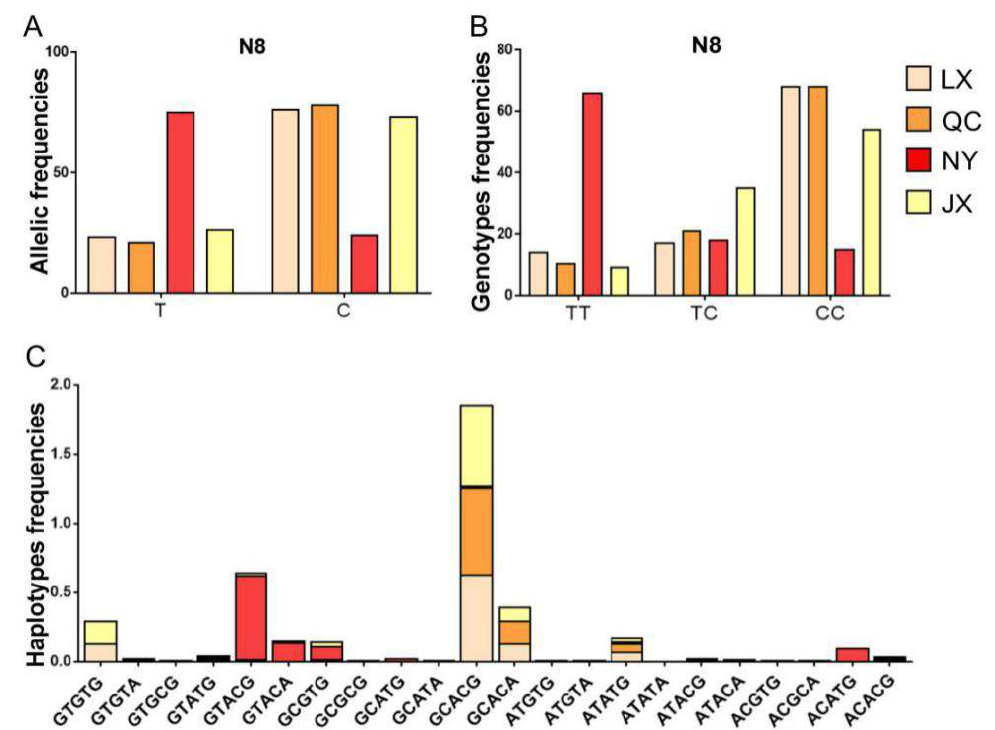
Figure 4. Allele, genotype, and haplotype distribution in four cattle breeds. ( A ) The allele frequency of the N8 locus of bovine PSAP in four cattle breeds; ( B ) the genotype frequency of the N8 locus of bovine PSAP in four cattle breeds; ( C ) the haplotype frequency of five SNPs of bovine PSAP 3’ UTR in four cattle breeds. QC: Qinchuan cattle; NY: Nanyang cattle; JX: Jiaxian red cattle; LX: Luxi cattle. Table 6. Relationship between four haplotypes of PSAP 3’ UTR and morphological traits in NY cattle. Morphological